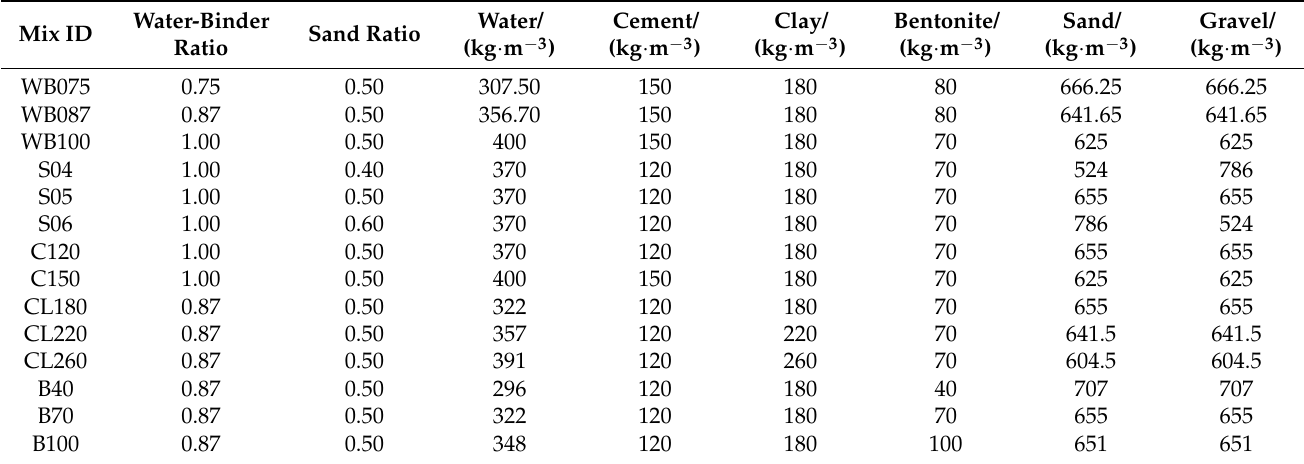
Table 1. Test Mix Proportion Scheme.